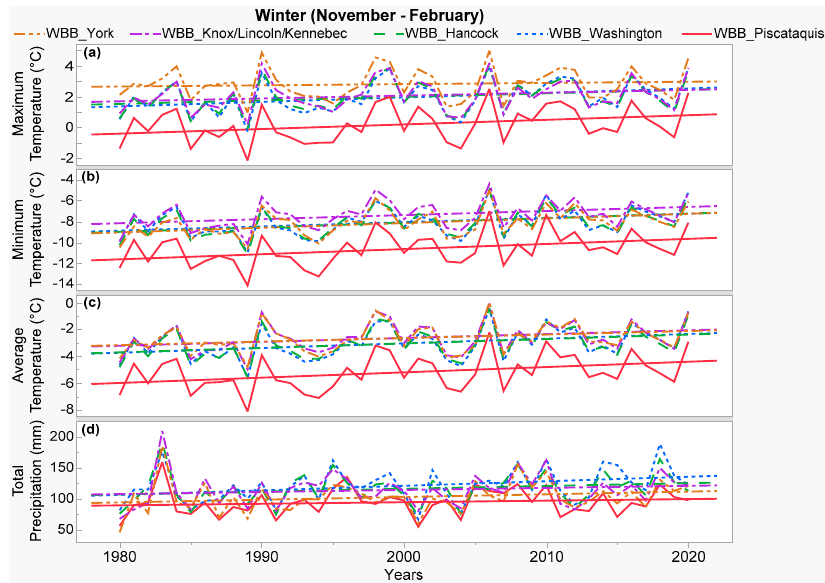
Figure 7. Historical (1980 to 2020) changes with fitted linear regression trendlines for the winter climate parameters: ( a ) maximum temperature, ( b ) minimum temperature, ( c ) average temperature, and ( d ) total precipitation, throughout the studied wild blueberry barrens (WBBs) in different counties from north-central (Piscataquis) and north-east (Washington, Hancock) to south-west (Knox, Lincoln, Kennebec, York) of Maine as shown in Figure 1.